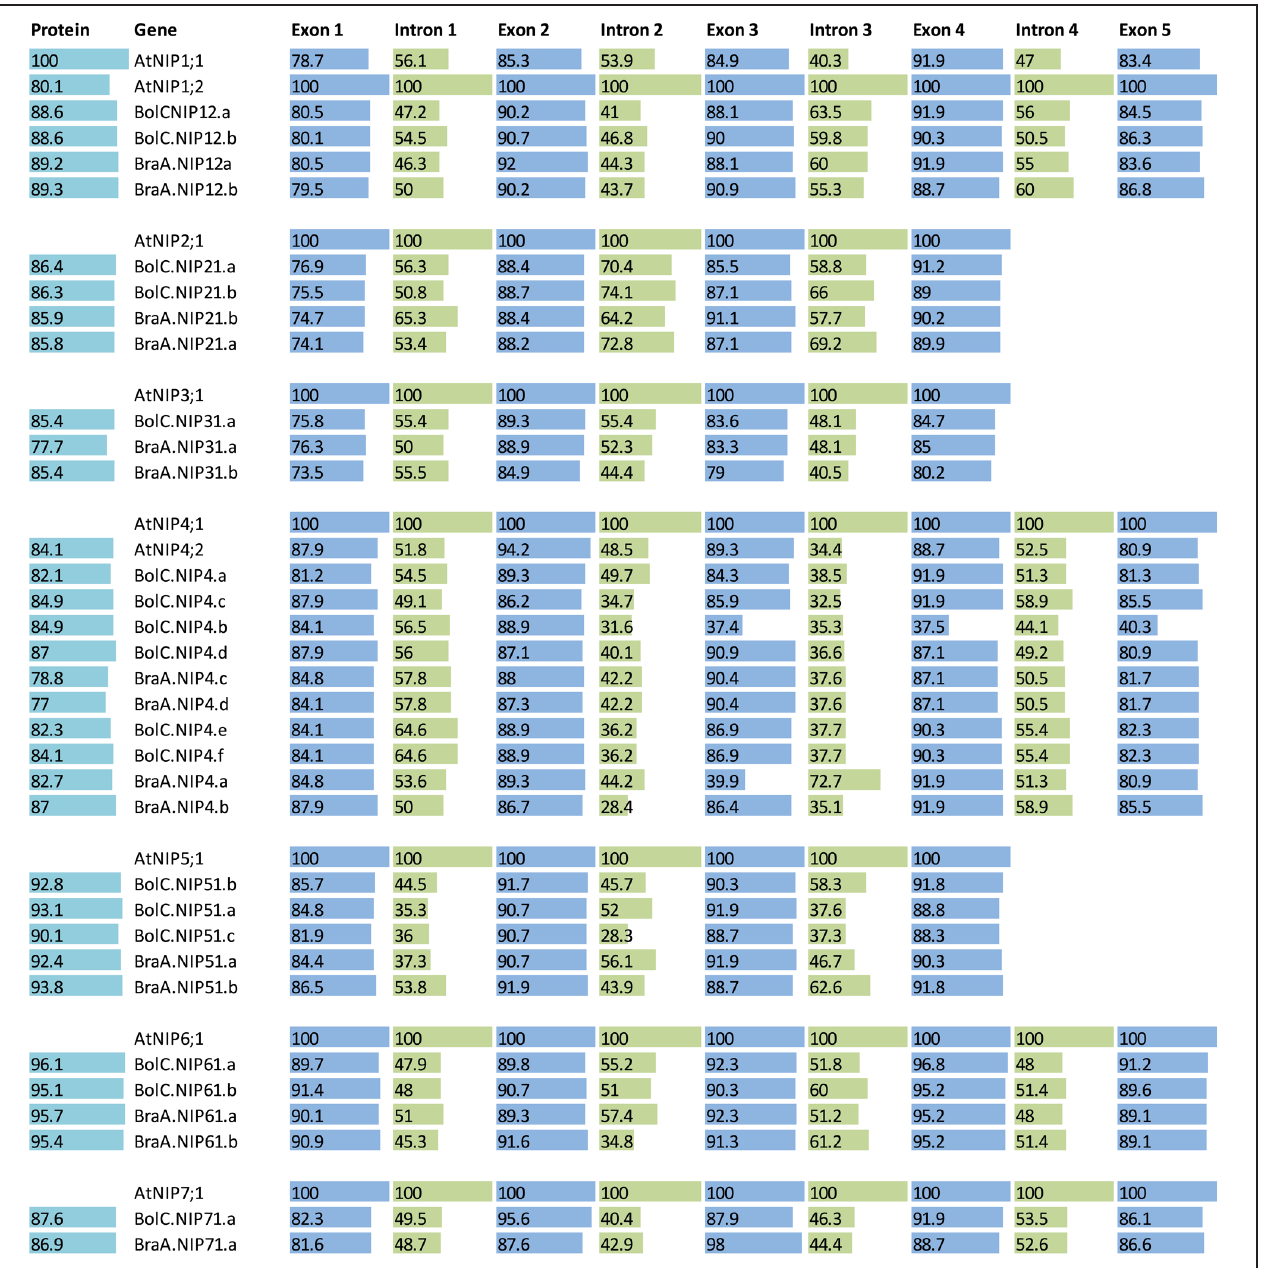
FIGURE 8 | Sequence identities of proteins and exons and introns of the different NIP subgroups. A protein and nucleotide identity chart was calculated from an alignment for each exon and intron and each amino acid sequence in each NIP subgroup separately. For each group the AtNIP isoform was set to 100% (bold letters) and the other